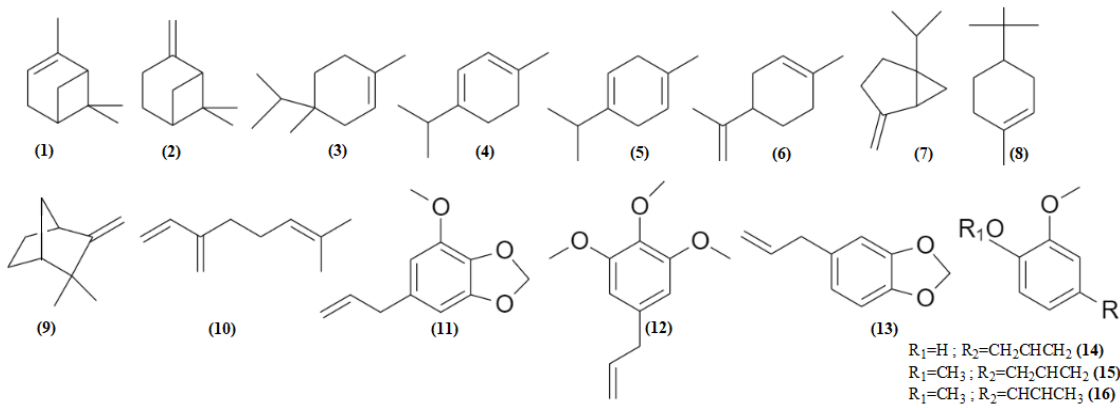
Figure 1. The goodness of fit of the one-compartment open model of levofloxacin after intravenous bolus injection, i.e., individual data fitting analyses (panel A); observation versus population prediction analysis (panel B) and observation versus individual prediction analysis (panel